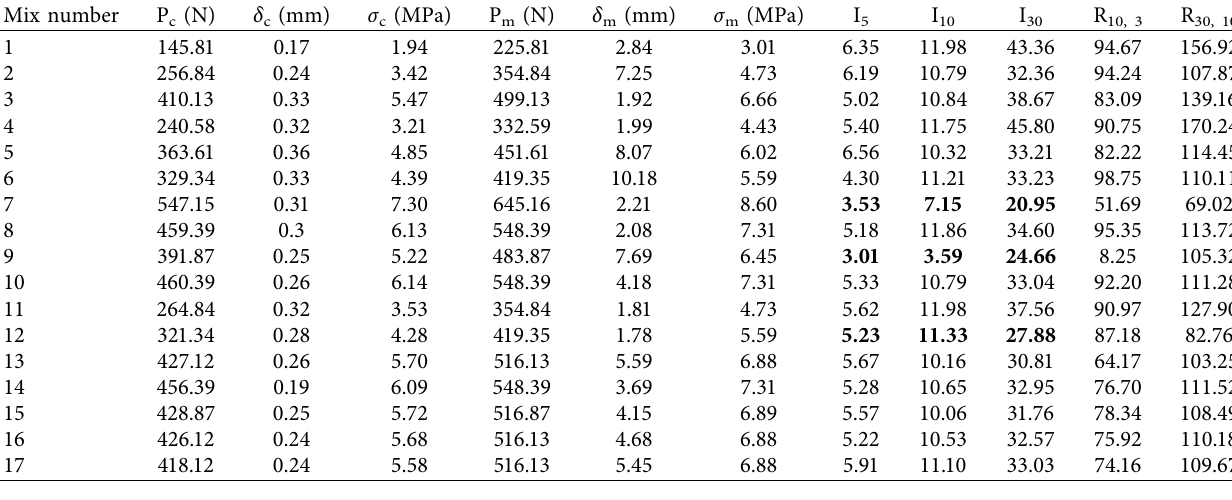
Table 7: Calculated results of mechanical properties of thin plates with different mix proportions and